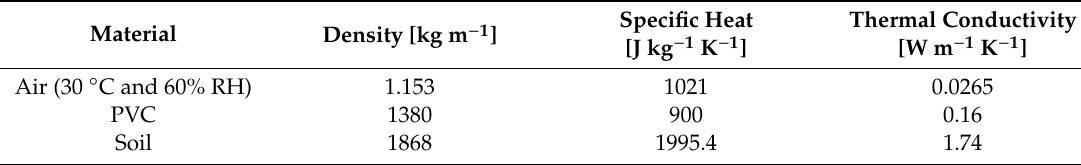
Table 4. Material properties of model validation 2 [41].